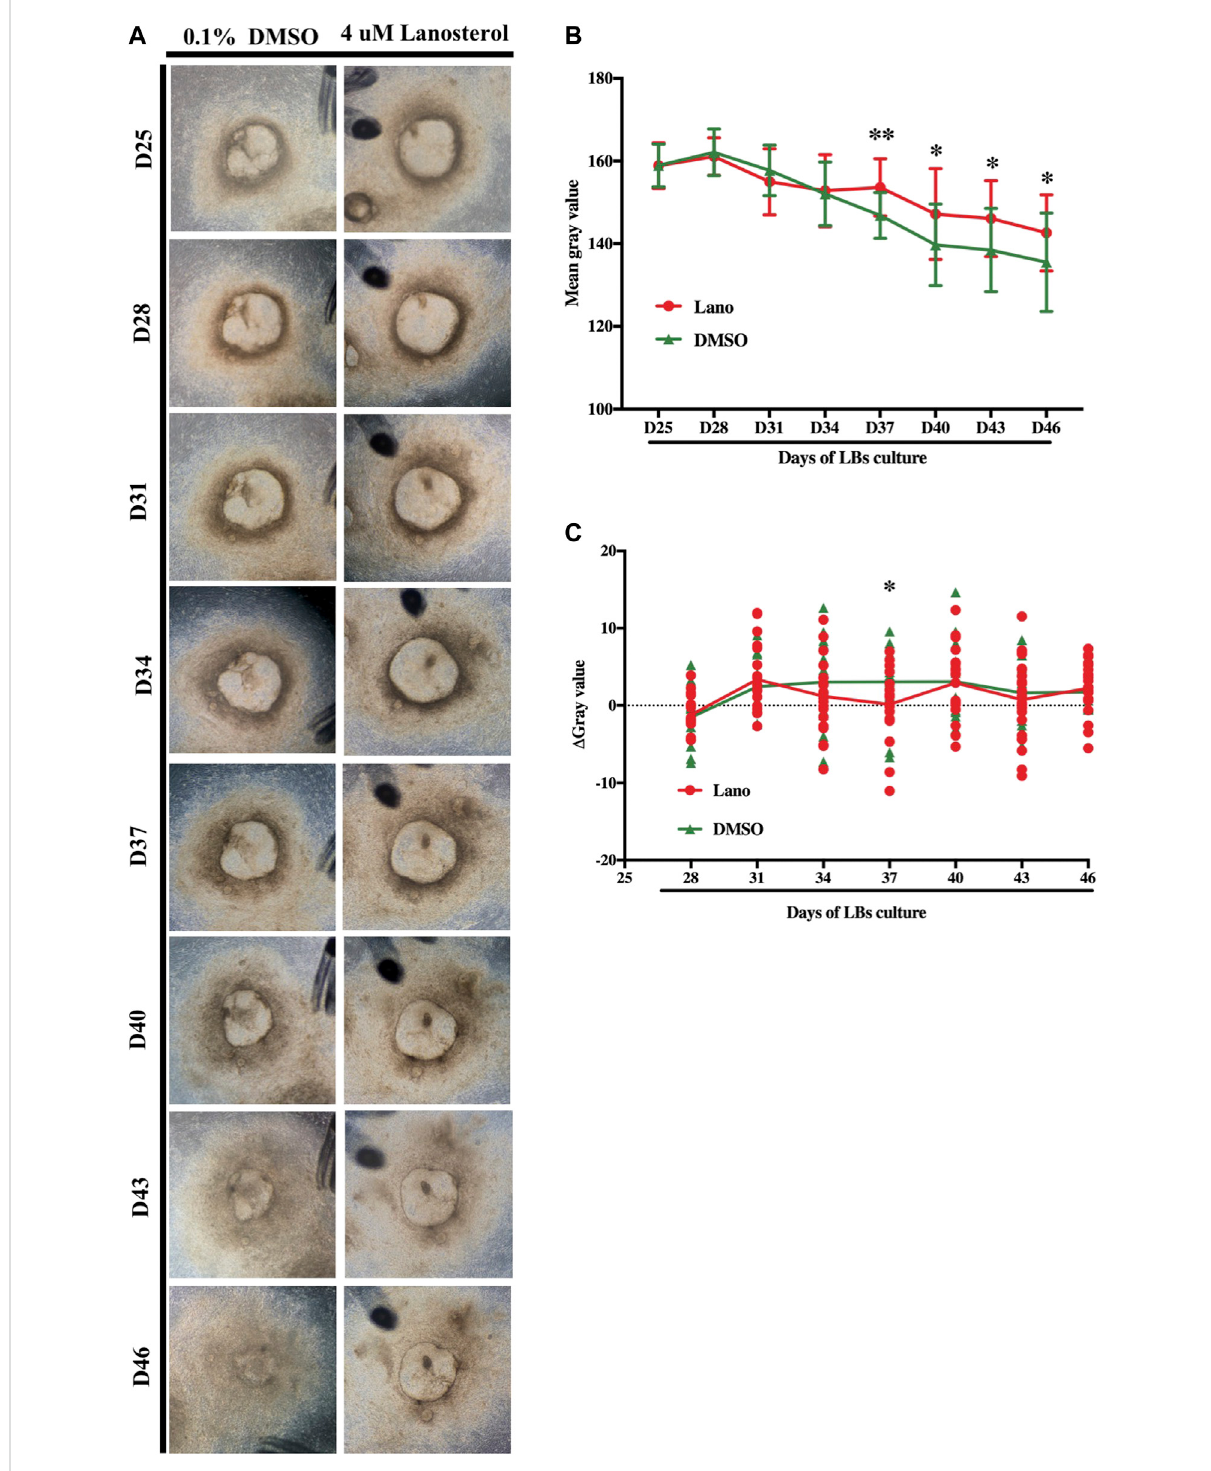
FIGURE 2 Development of lanosterol treated LBs. (A) Representative pictures of control and lanosterol treated LBs from D25 to D46. (B) The opacity degreesofLBswereevaluatedbymeangrayvalueusingtheImageJsoftware. (C) ThedecreaserateofmeangrayvalueofLBswasrepresentedusing Δ Gray value ( Δ Gray value = (gray value D(n) − gray value D (n + 3))/3). At least 12 LBs in each group from three independent experiments were examined. Bars represent mean ± SD. * p < .05, ** p < .01. Scale bar:1 mm. DMSO, dimethyl